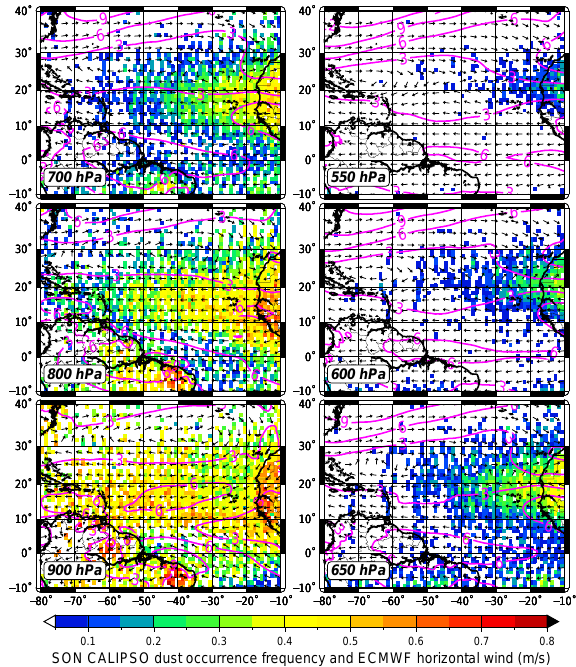
Fig. 13. Same as Fig. 10 but for fall (SON). Fig. A4. Same as Fig. A1 but for fall